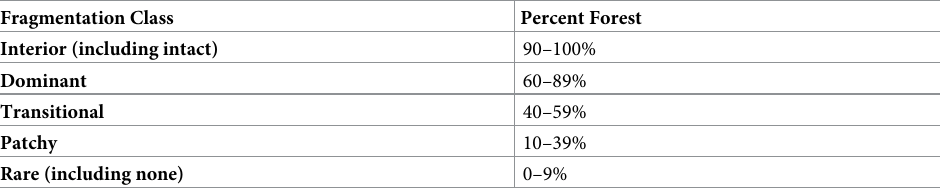
Table 3. Forest fragmentation classes used, based on percent forest within various window